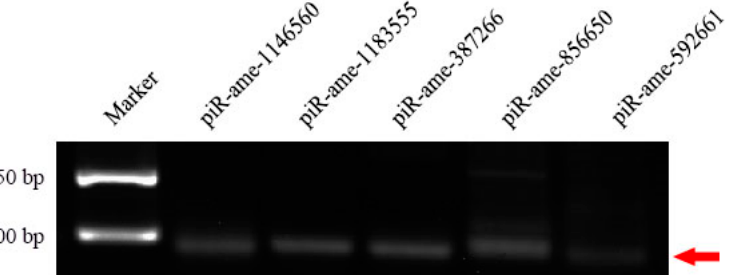
Figure 6. Agarose gel electrophoresis for amplification products from Stem-loop RT-PCR of five randomly selected DEpiRNAs. The red arrow indicates the signal band with the expected size (about 60–80 bp).